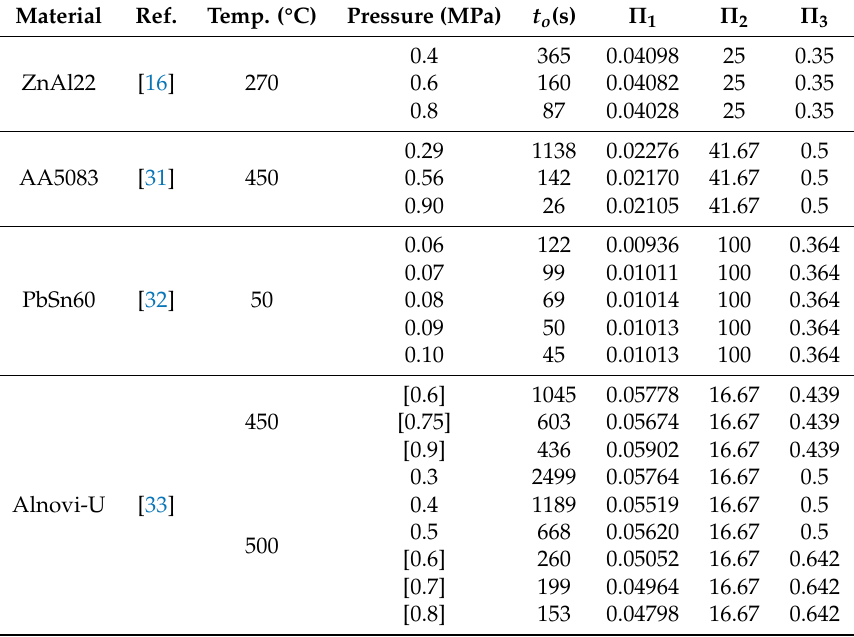
Table 1. Tests data. Pressure values in square brackets correspond to new test. Material